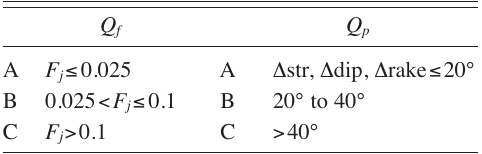
Table V. Fault-plane solution quality factors Q f and Q